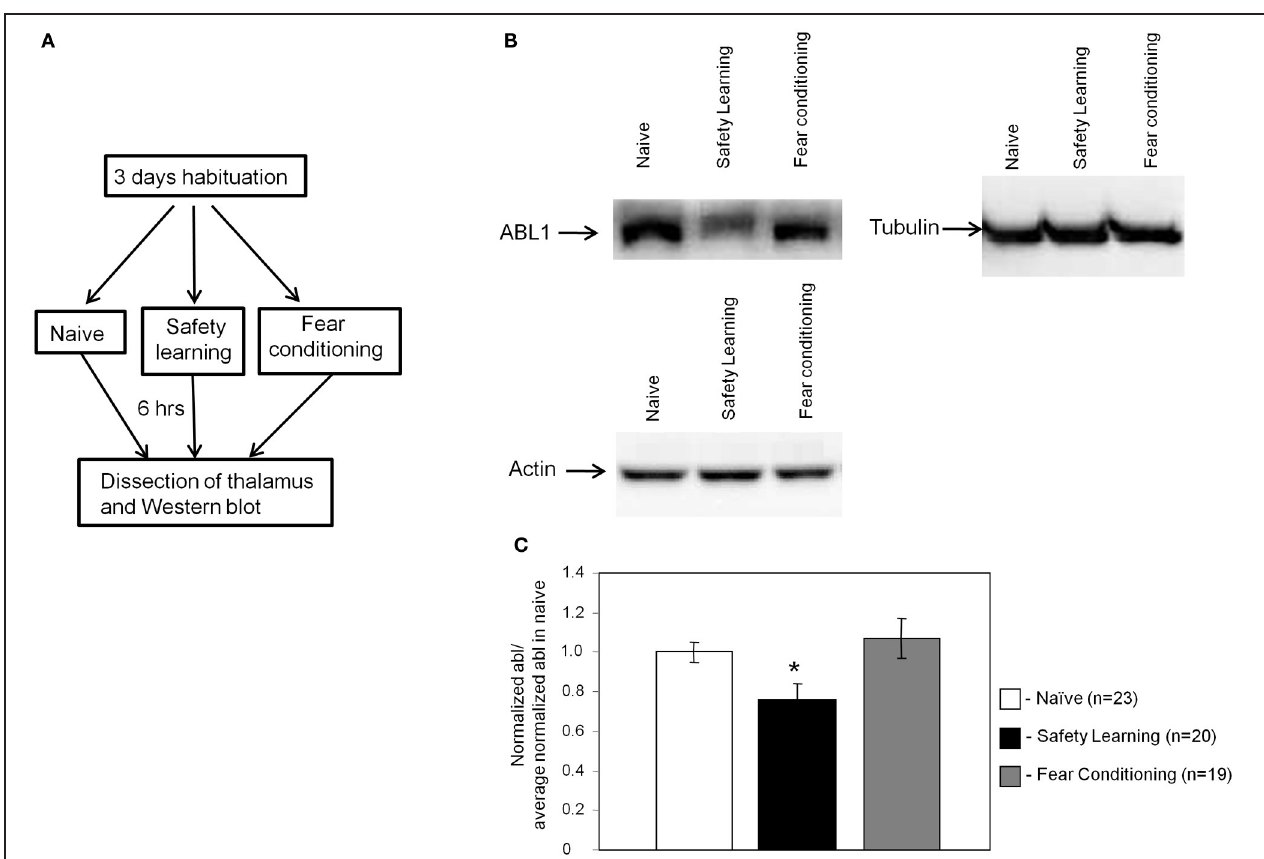
and actin in various animal groups. (C) The ratio of normalized ABL1 of various experimental groups to the averaged normalized ABL1 in naïve is shown. ABL1 protein level is lower in safety learning trained group [ F ( 2 ) = 4 . 195, ∗ p < 0 . 03] when compared to the fear conditioning ( p < 0 . 009) or naïve ( p < 0 . 04) groups. The level of ABL1 in fear conditioning group was not different from its level in the naïve group ( p = 0 .